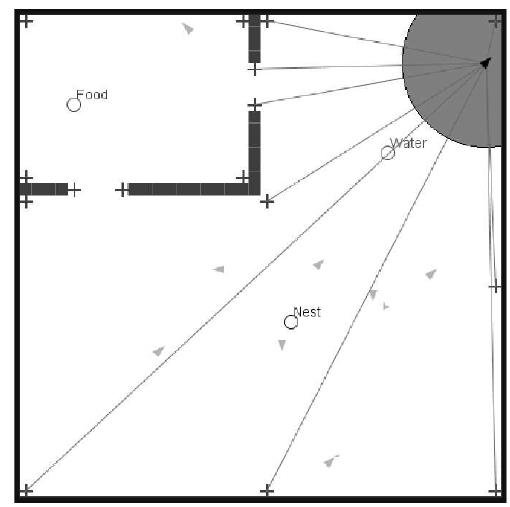
Figure 1. An animat (small dark triangle) in its environment, made of landmarks (crosses), obstacles (solid rectangles), resources (labelled circles) and possibly other animats (triangles). Visible landmarks are linked to selected animat, and its visibility range is put in evidence with the grey circle around it.